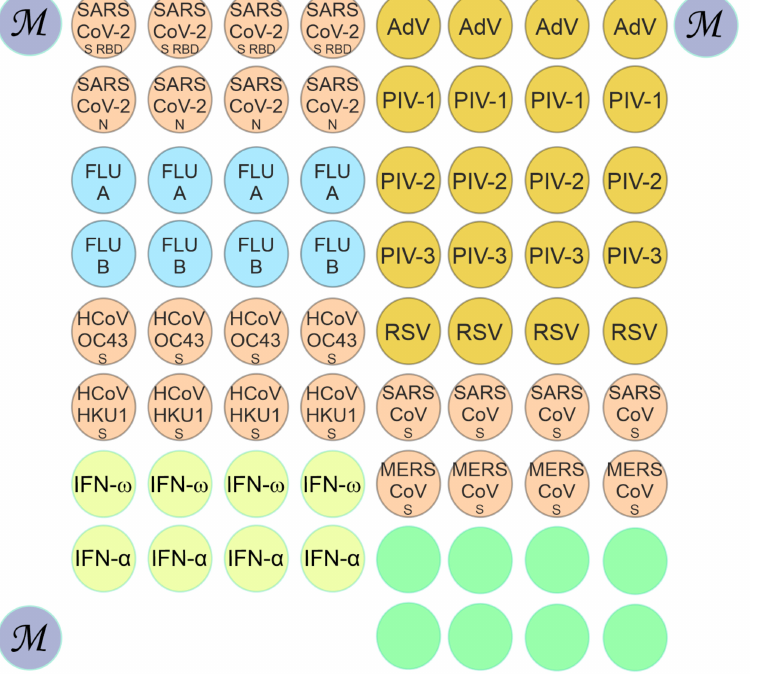
Figure 1. Configuration of the microarray for detecting antibodies against respiratory viruses and type I IFNs. Abbreviations: SARS-CoV-2 S RBD—SARS-CoV-2 spike receptor-binding